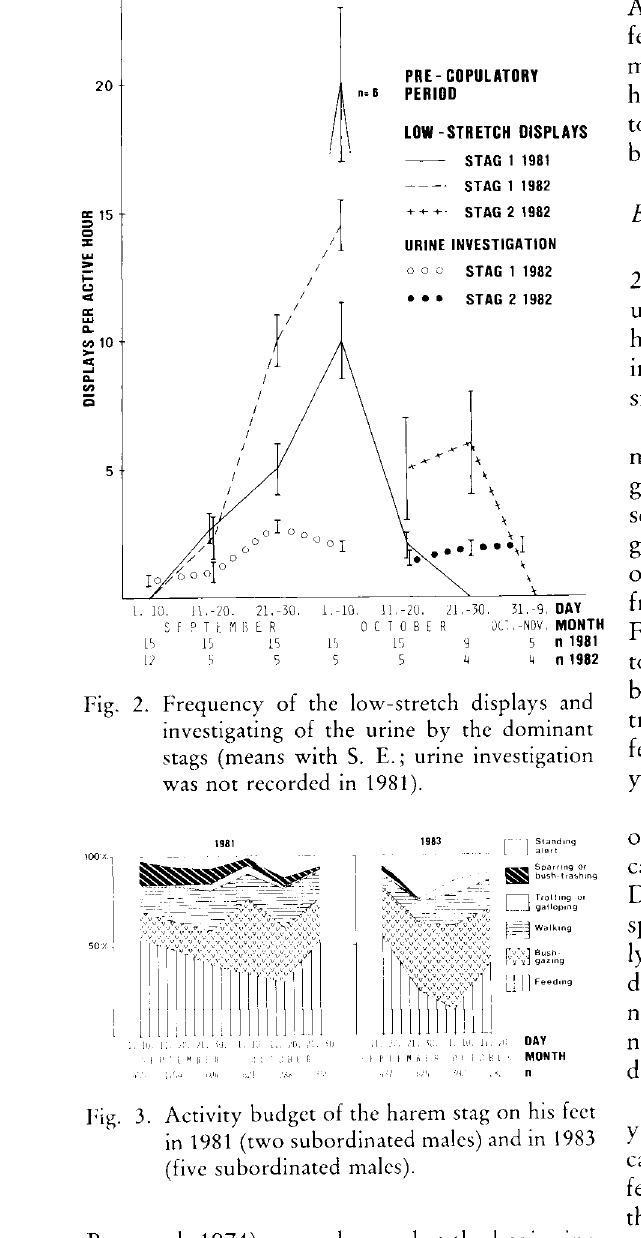
Fig. 3. Activity budget of the harem stag on his feet in 1981 (two subordinated males) and in 1983 (five subordinated